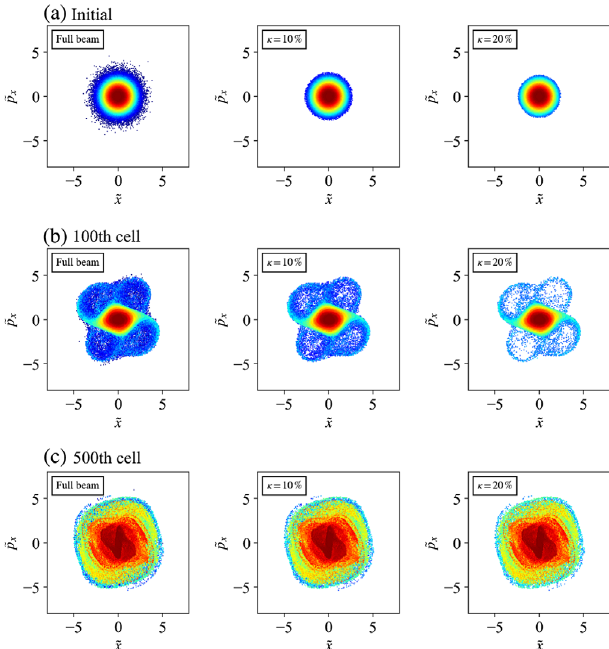
FIG. 6. Phase-space configurations at ν 0 ¼ 0 . 275 with three different tail-truncation factors ( κ ¼ 0 , 10, 20), observed at (a) the transport entrance, (b) 100th FD cell, and (c) 500th FD